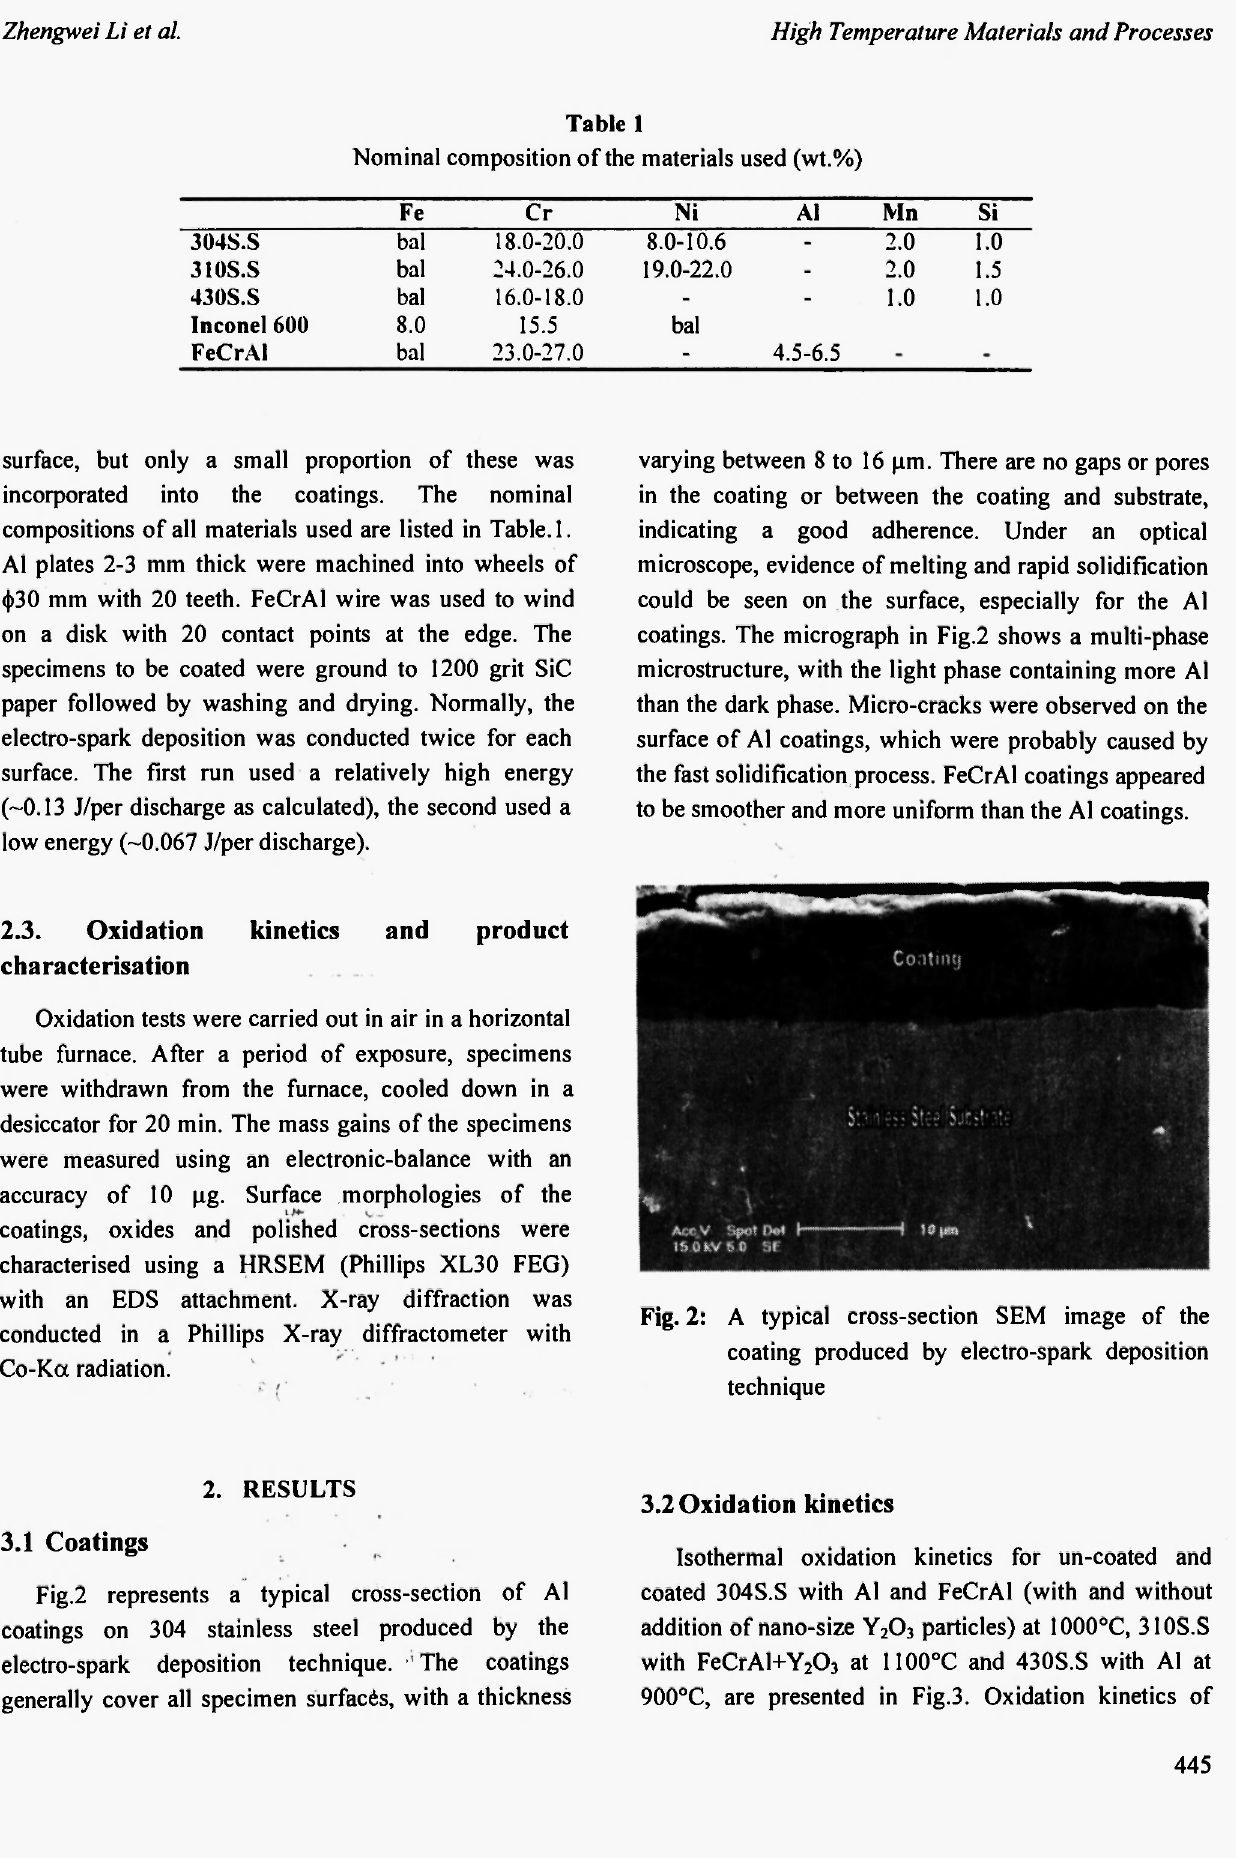
Isothermal oxidation kinetics for un-coated